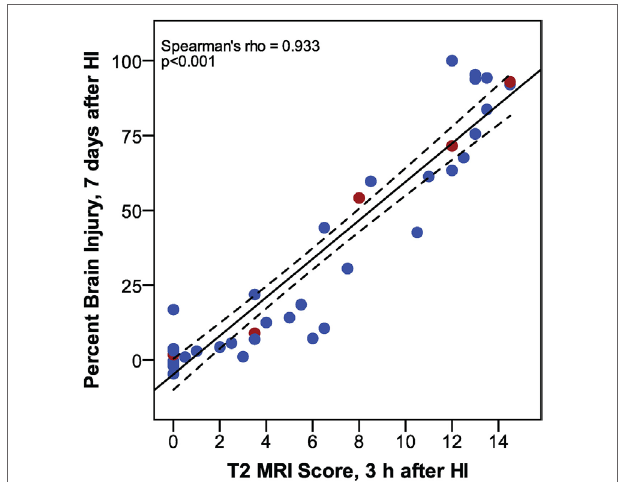
FigUre 3 | Phase 1: correlation between T2 magnetic resonance imaging scores, 3 h after hypoxic ischemia (HI), and percent brain injury measured in histological brain sections, 7 days after HI. ( n = 43. Samples shown in Figure 2 are colored